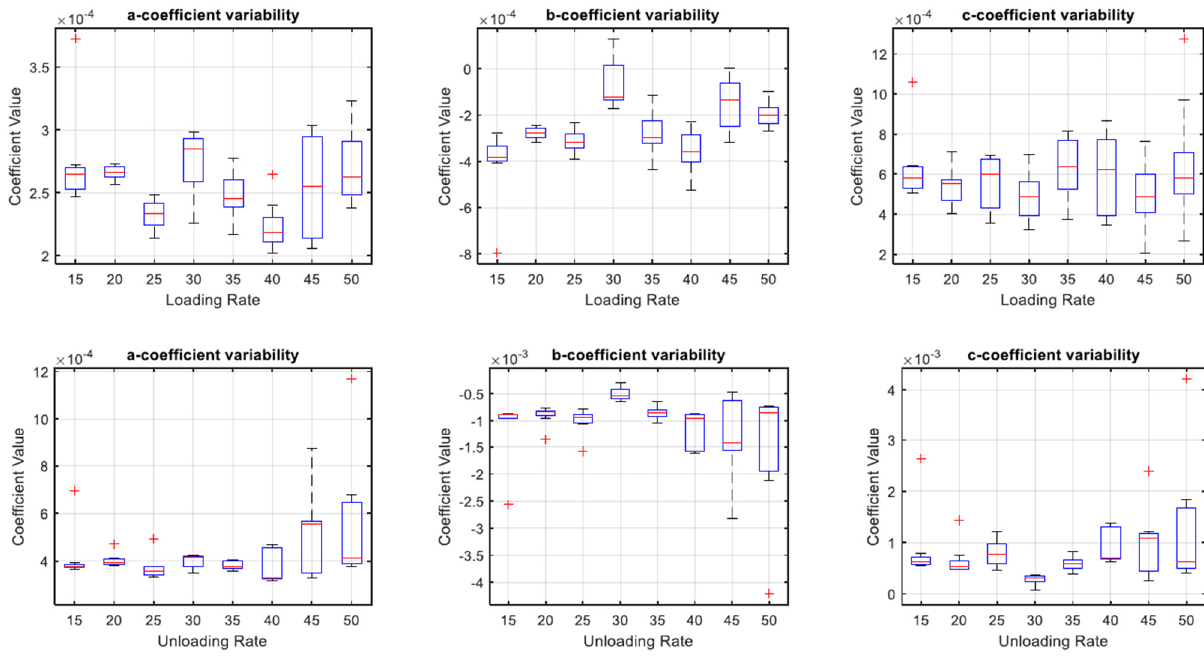
Figure 20. Box Plots of Coefficient Variability for Equation (2).